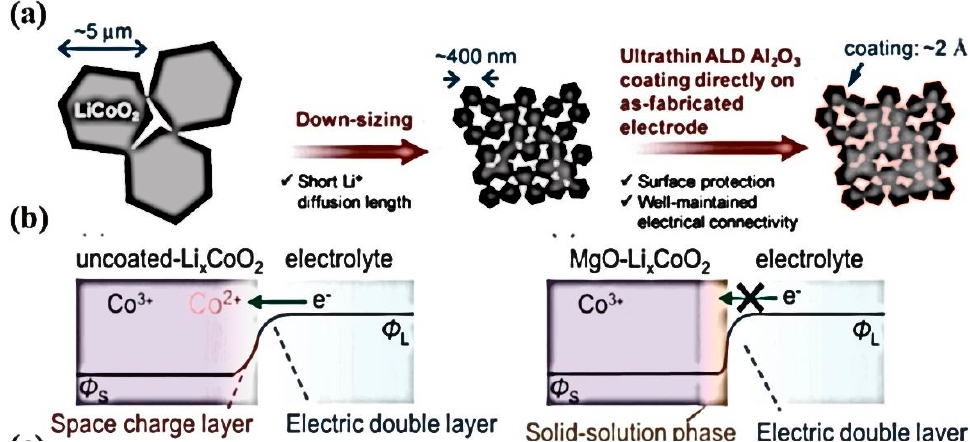
Figure 17. ( a ) Schematic view of modification mechanism through the ultrathin Al 2 O 3 ALD coating ( b ) Schematic view of the electronic structure of uncoated and MgO-coated LCO/electrolyte interface upon electrolyte immersion ( φ S and φ L are the electrochemical potentials of the electrode and electrolyte, respectively)